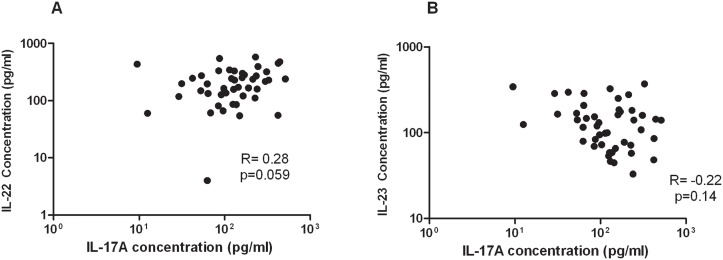
Correlation between IL-17A and other Th17 cytokines IL-22 (A) and IL-23 (B) levels in PBMCs from children with high and low pneumococcal carriage density (N = 46).The Spearman test was used to correlate the cytokine levels.